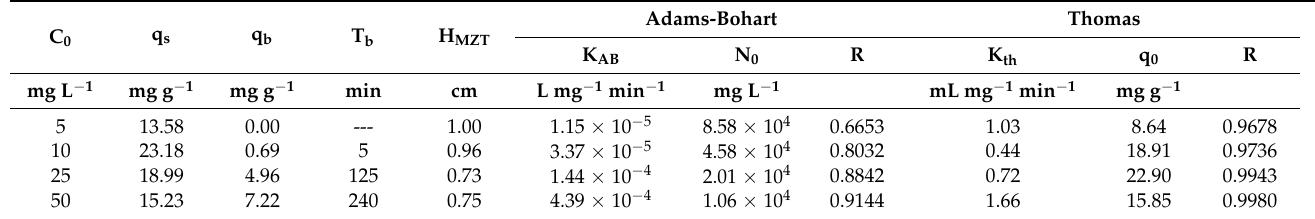
Table 6. Parameters of the studied models of breakthrough curves for DB-86 on column fixed